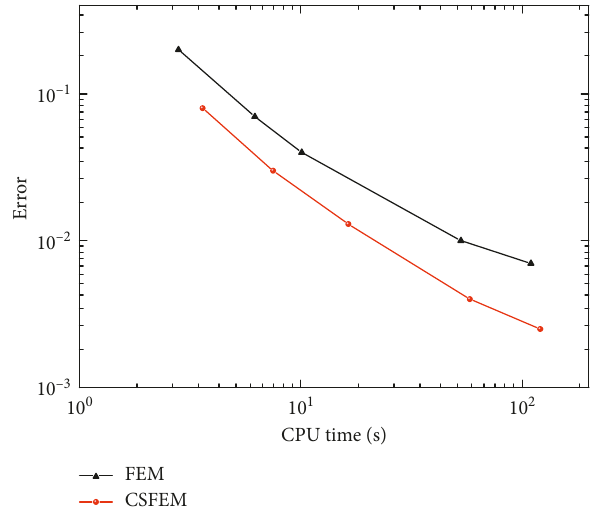
Figure 8: Variation of vertical displacement u ( z 0) of the singer-player PCMs strip. (cid:31)